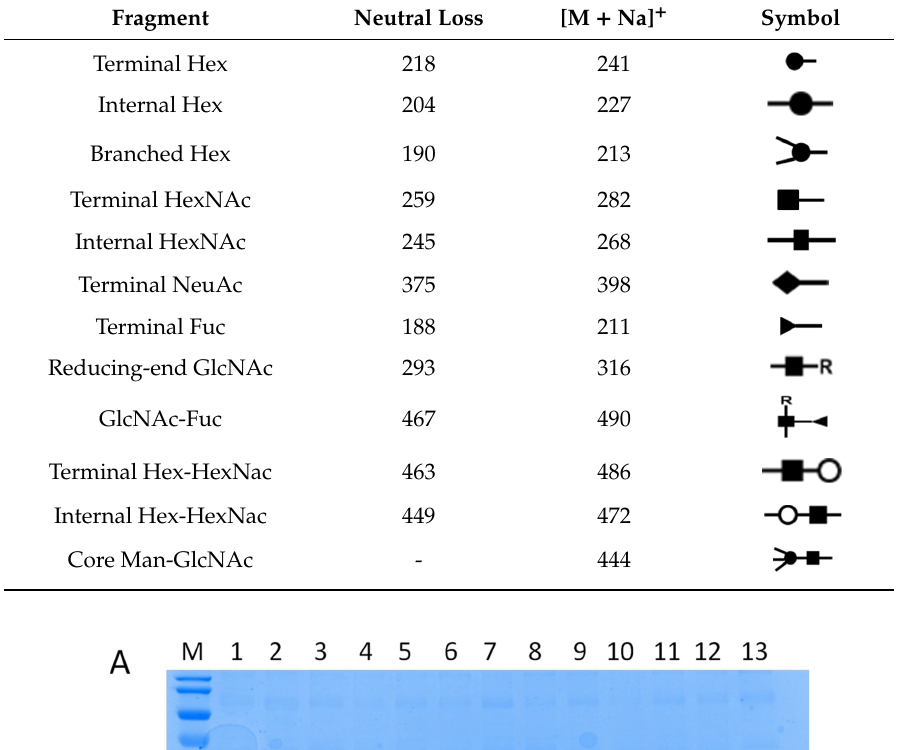
Table 1. Major N-glycans in sera of healthy controls and rheumatoid arthritis patients. Table 2. Major ion fragments in MS n .